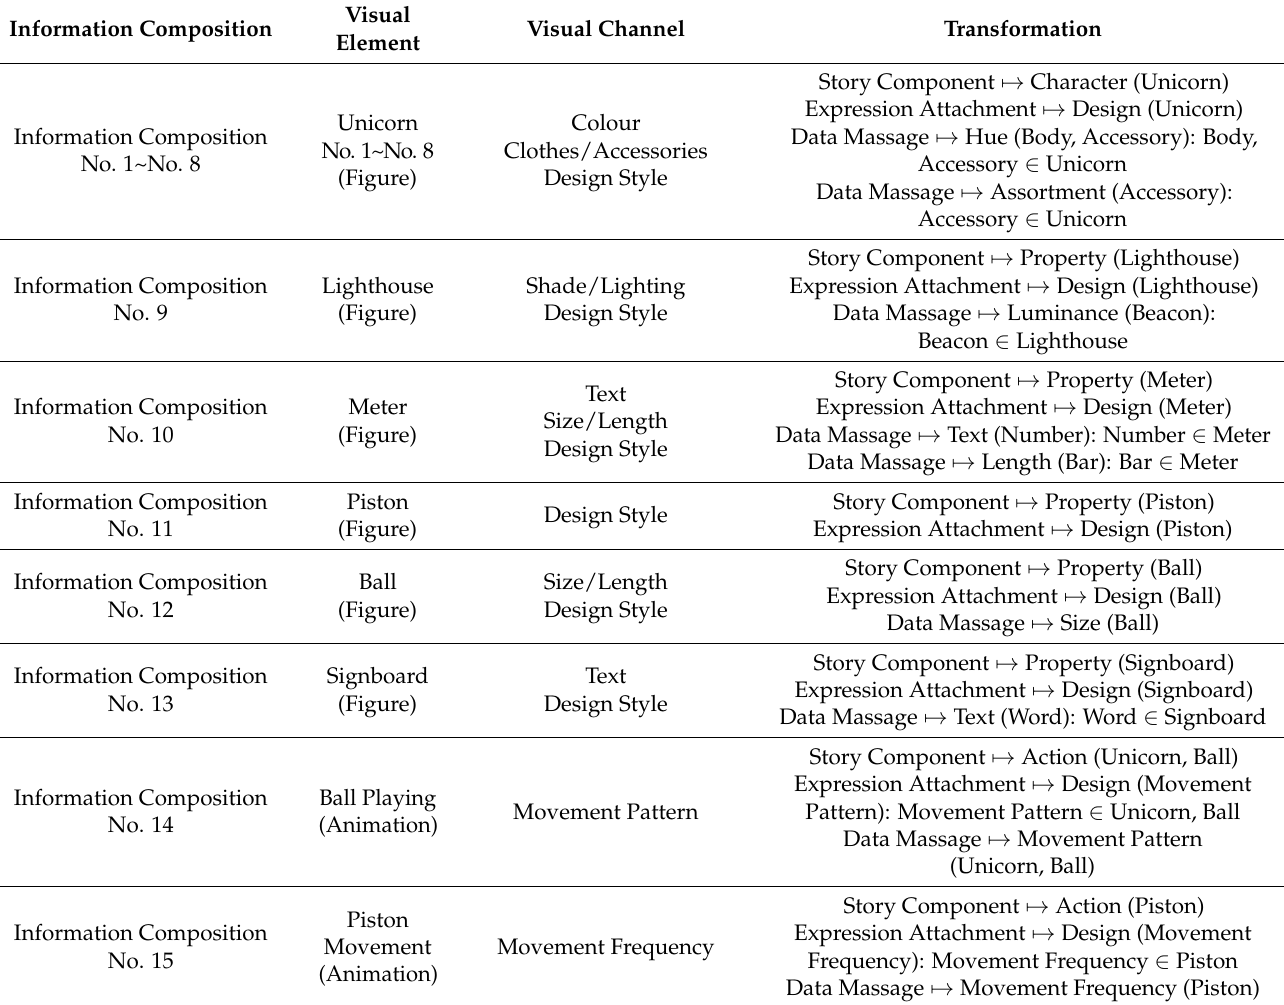
Table 3. Mapping between information units and visual